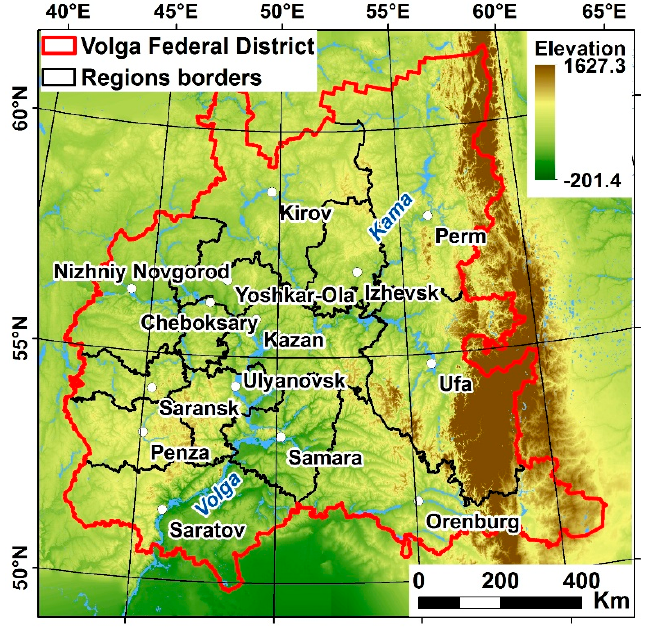
Figure 1. Study area location.